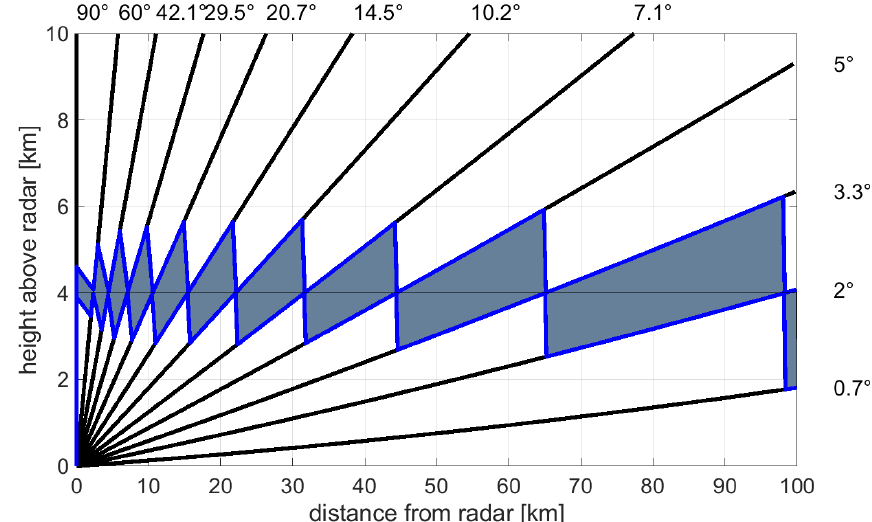
Figure 1. Radar scan strategy for a single azimuth. The altitudes and distances scanned for each of the 12 elevation angles are shown. The shaded regions illustrate the uncertainty of the radar observation at 4-km